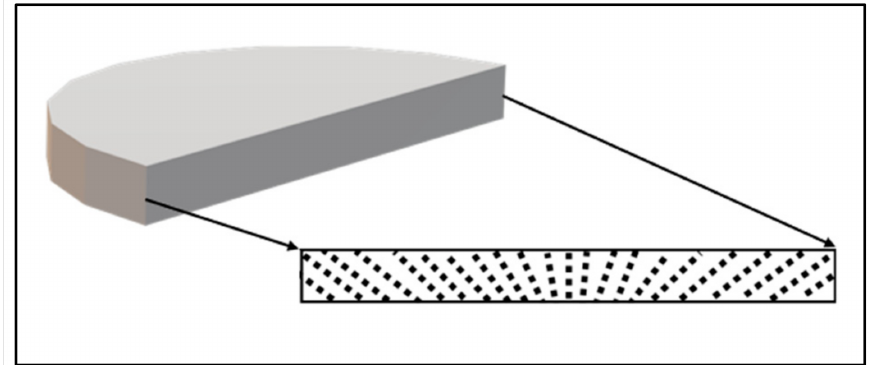
Figure 5. Cross-sectional surface of MRE for FESEM